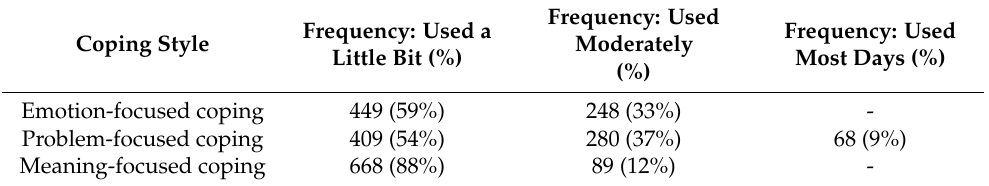
Table 2. Summary of coping strategies reported by the